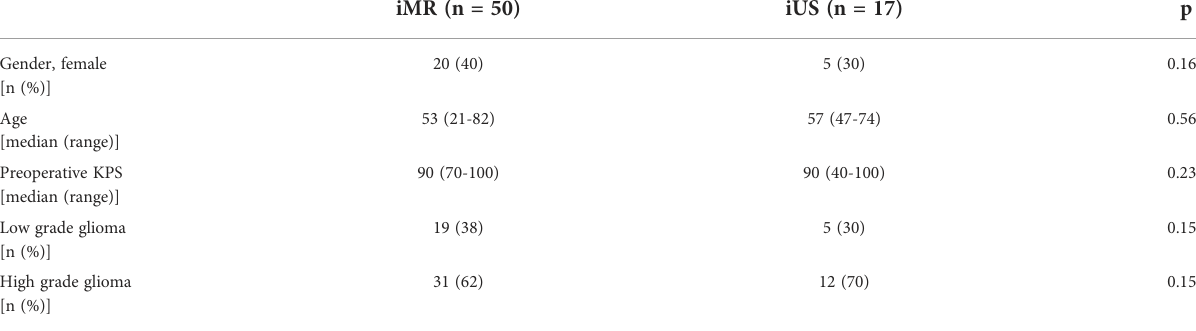
TABLE 1 Socio-demographic and clinical